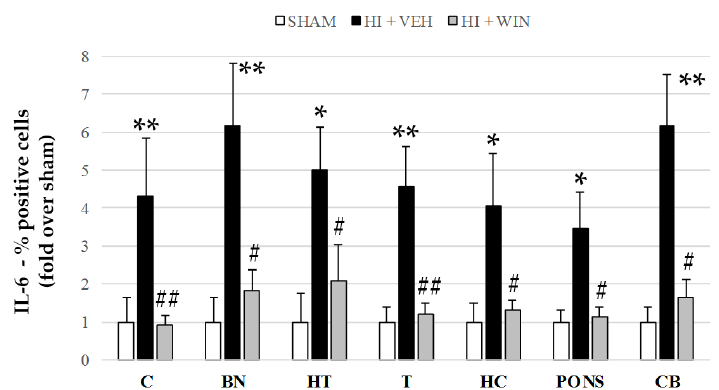
Figure 6. Evaluation of IL-6 expression in different brain regions evaluated after sham or HI (and vehicle or WIN treatment) in fetal lambs. Samples from both hemispheres were analyzed in triplicate by flow cytometry ( n = 6) for each animal and condition. Values given as the mean ± SD of the percentage of IL-6 positive cells. (*) ANOVA p < 0.05 vs. sham and HI + WIN; (**) ANOVA p < 0.01 vs. sham and HI + WIN; (#) ANOVA p < 0.05 vs. HI + VEH; (##) ANOVA p < 0.01 vs. HI + VEH. Sham, n = 6; HI + VEH, n = 6; HI + WIN, n = 6. (C: cortex; BN: basal nuclei; HT: hypothalamus; T: thalamus; HC: hippocampus; CB: